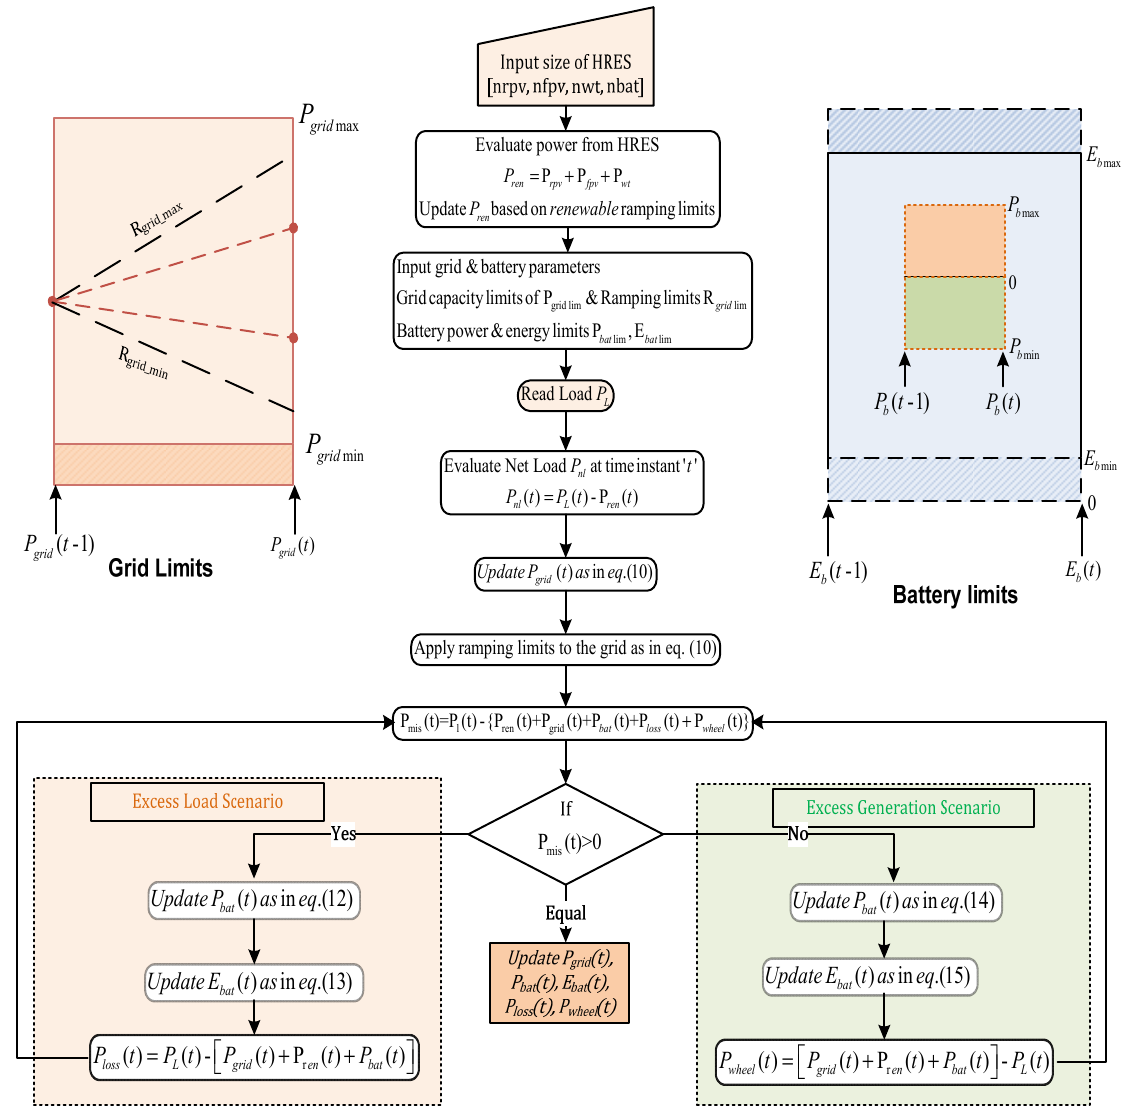
Figure 11. Flow chart for the energy management system.